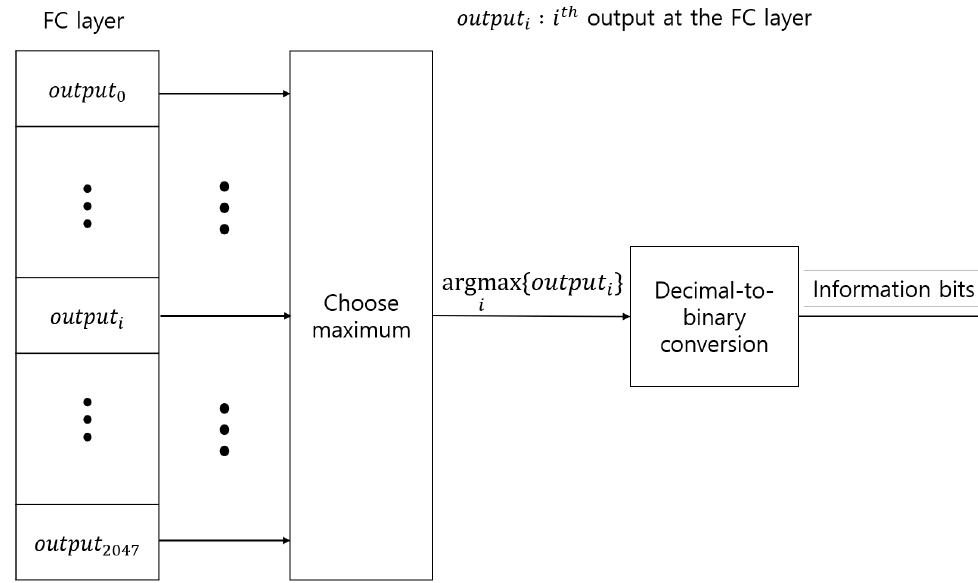
Figure 4. Message estimation of R ( 2,4 ) from the output of FC